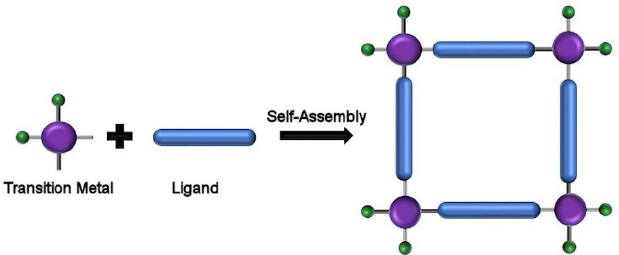
Figure 18. Representation of the tetragonal metal complex construction.